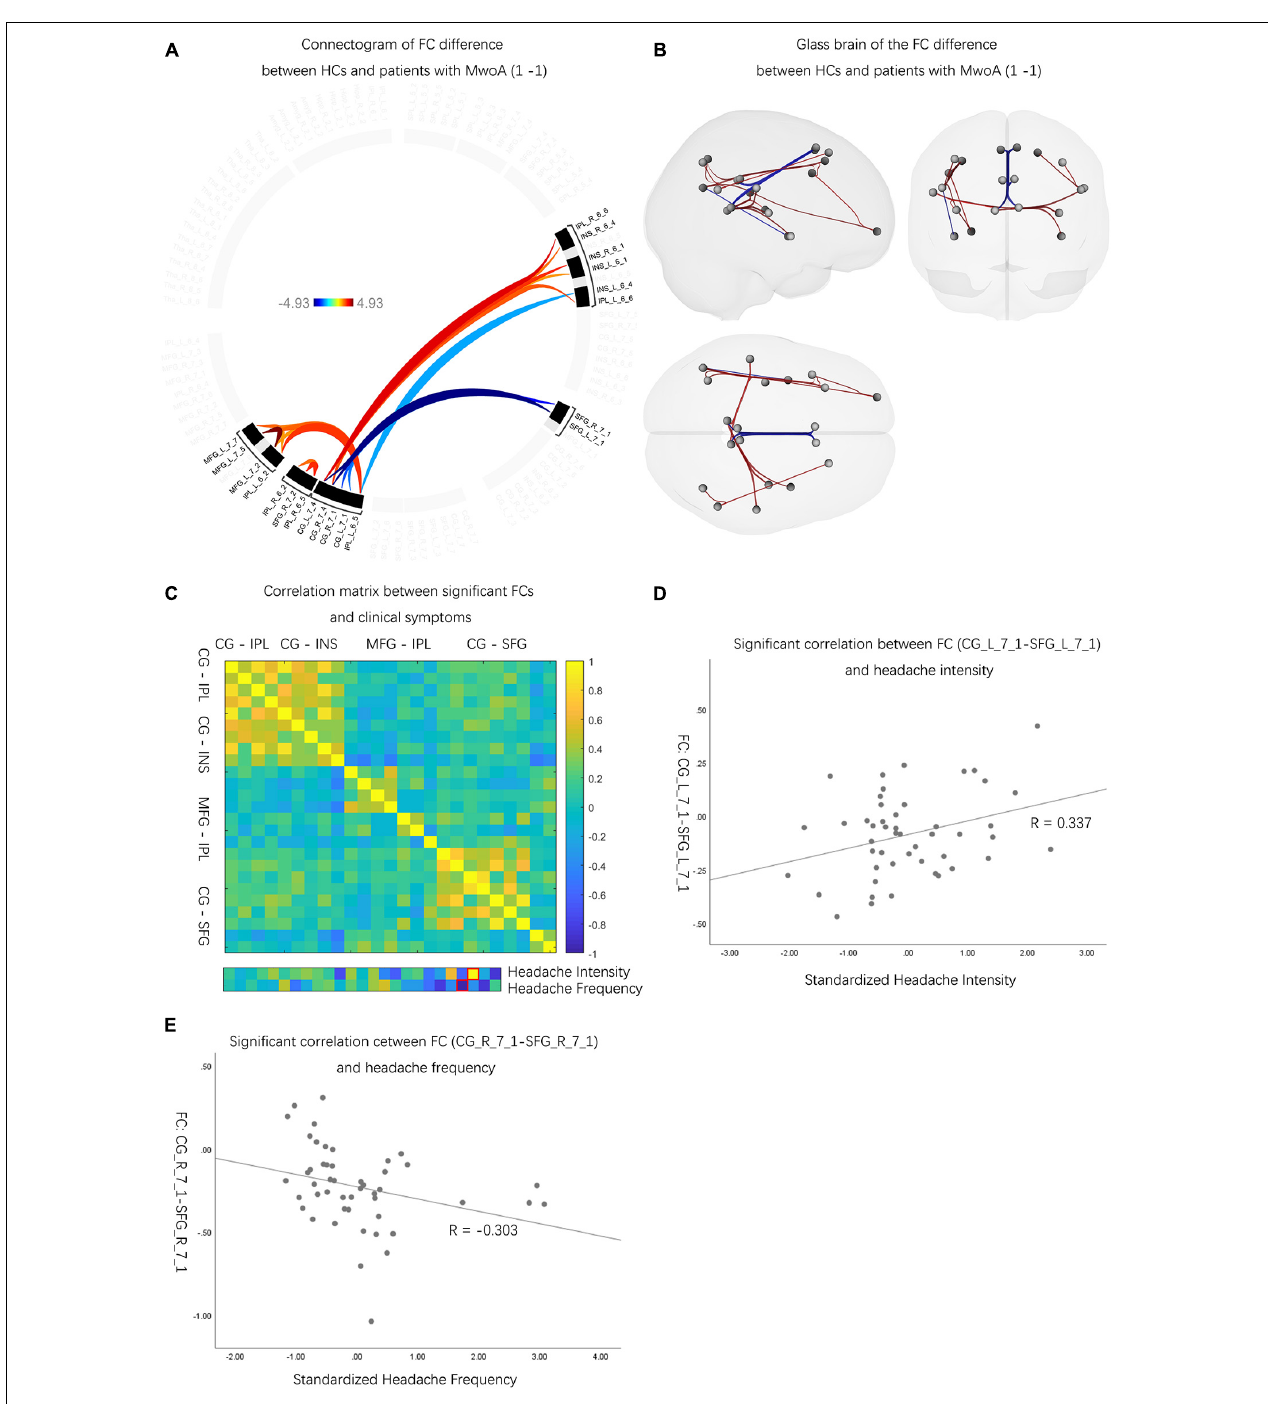
FIGURE 2 | The neuro activities difference between patients with MwoA and HCs. (A) Patients with MwoA manifested significantly decreased and increased FCs compared with those in HCs, and the color bar represents the t -value of FC. (B) Patients with MwoA manifested significantly decreased FCs between CG and IPL, CG and INS, MFG and IPL, and within IPL subregions, MFG subregions. Moreover, patients with MwoA had significantly increased FCs between CG and SFG. Red connection lines represent an increased FC of HCs than patients with MwoA, and blue lines vice versa . (C) Two FCs were significantly correlated with headache intensity and frequency, with the red rectangle circling the significantly correlated FCs. The color bar represents the Pearson correlation coefficient, and the closer the absolute value is to 1, the higher the correlation is, and vice versa . (D) The FC between the left CG and the left SFG was significantly correlated with headache intensity ( r = 0.337, p < 0.05). (E) The FC between the right CG and the right SFG correlated with headache frequency ( r = –0.303, p < 0.05). MwoA, migraine without aura; HC, healthy control; FC, functional connectivity; L, left hemisphere; R, right hemisphere; SFG, superior frontal gyrus; MFG, middle frontal gyrus; SPL, superior parietal lobule; IPL, inferior parietal lobule; INS, insular gyrus; CG, cingulate gyrus; Amyg, amygdala; Hipp, hippocampus; Tha, thalamus.